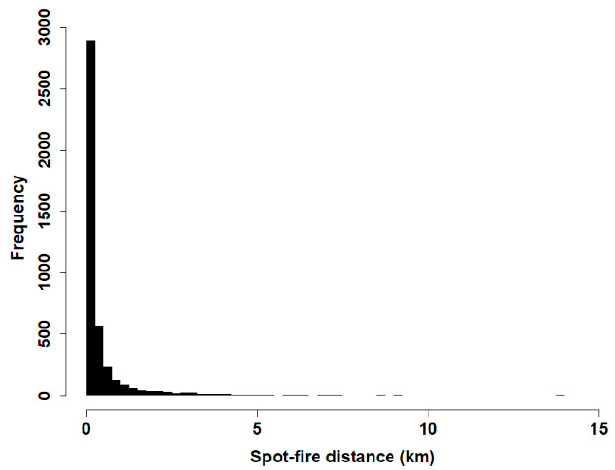
Figure 5. Distribution of distances of all spot fires (n = 4219) from every source fire pooled.